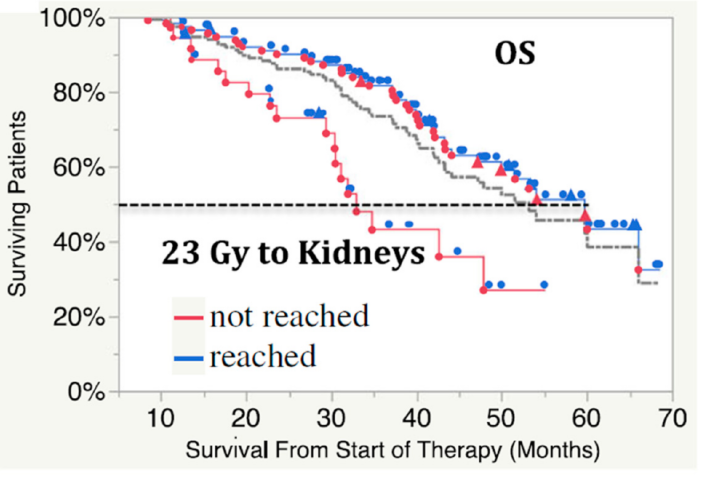
Figure 6. Overall survival in 177 Lu-DOTA-octreotate therapy in relation to 23 Gy achieved to the kidney (blue curve), or not due to hematological toxicity (red curve). Gray curve: all patients OS. Red symbol: patients died. Blue symbol: patients alive (Reprinted with permission from Ref. [36]. Copyright 2021